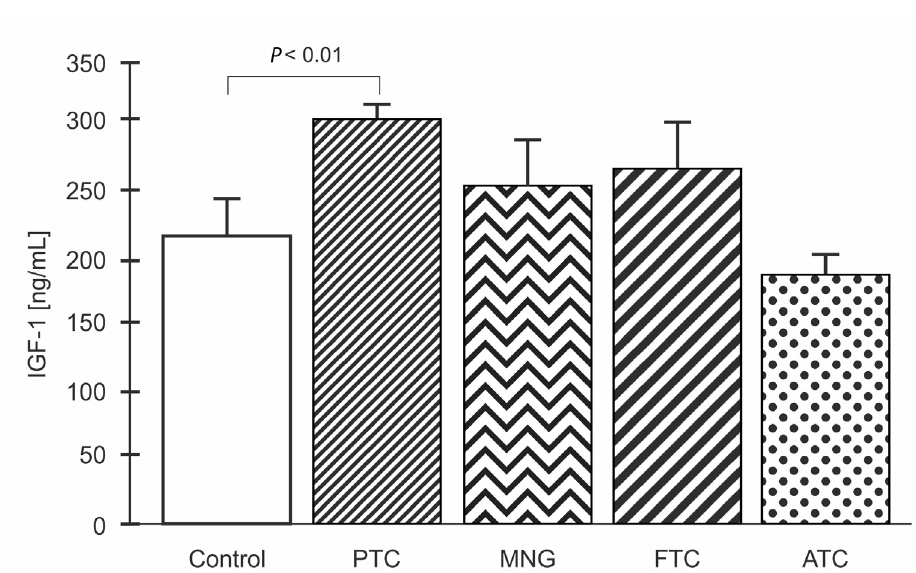
Fig. 1. Mean serum concentration of IGF-1 (ng/mL) in patients diagnosed with papillary thyroid cancer, follicular thyroid cancer, anaplastic thyroid cancer, multinodular goiter and in healthy volunteers. Bars represent mean ± SEM